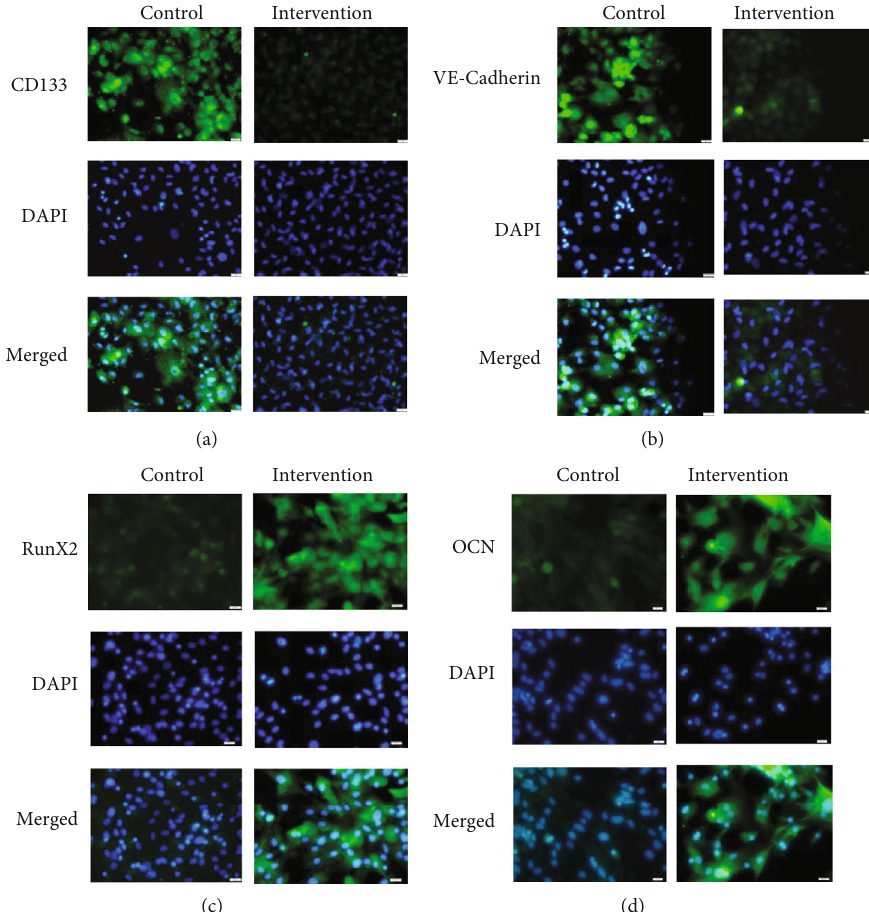
Figure 2: Immuno fl uorescence staining of endothelial cell and osteoblast marker proteins in AGE- and β -glycerophosphate-induced EPCs. Expressions of (a) CD133, (b) VE-cadherin, (c) RUNX2, and (d) OCN in EPCs were analyzed by immuno fl uorescence staining; nuclei were stained with DAPI. Panels on the left show control treatment (untreated cells); panels on the right show cells 7 days following AGE treatment. Each fi eld of view was randomly selected under a microscope; magni fi cation, × 200. AGE: advanced glycation end product; EPC: endothelial progenitor cell; OCN: osteocalcin; RUNX2: runt-related transcription factor